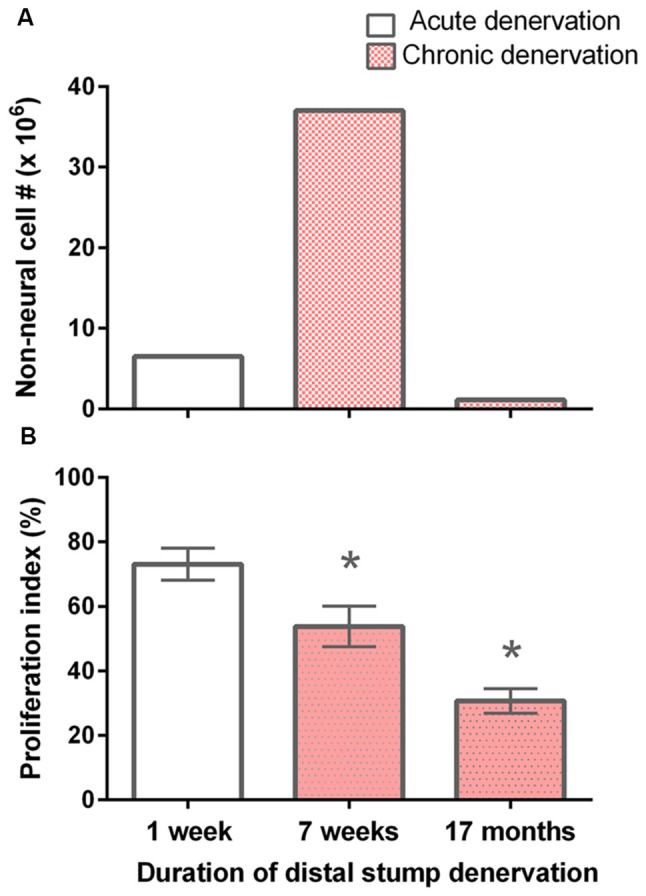
Decline in the number of non-neuronal cells and the proliferative capacity of S-100 positive SCs with chronic denervation. (A) Non-neuronal cells isolated from acutely (7 days) and chronically (7 weeks and 17 months) denervated distal nerve stumps of the sciatic nerve and its tibial (TIB), common peroneal (CP), and sural nerve branches, namely control acute and experimental chronically denervated distal nerve stump form the right and left hindlimbs, respectively. The cells were counted in small aliquots of single cell suspensions. (B) The mean (± SE) of the proliferation index. The index is the number of S-100 positive SCs that, in co-cultures with isolated dorsal root ganglion (DRG) neurons for 5 days, were labeled with 3H-thymidine and hence were dividing, expressed as a percentage of the total number of S-100 positive SCs. The proliferation indices at 7 days, 7 weeks and 17 months were significantly different from one another as indicated by *’s (p < 0.025).